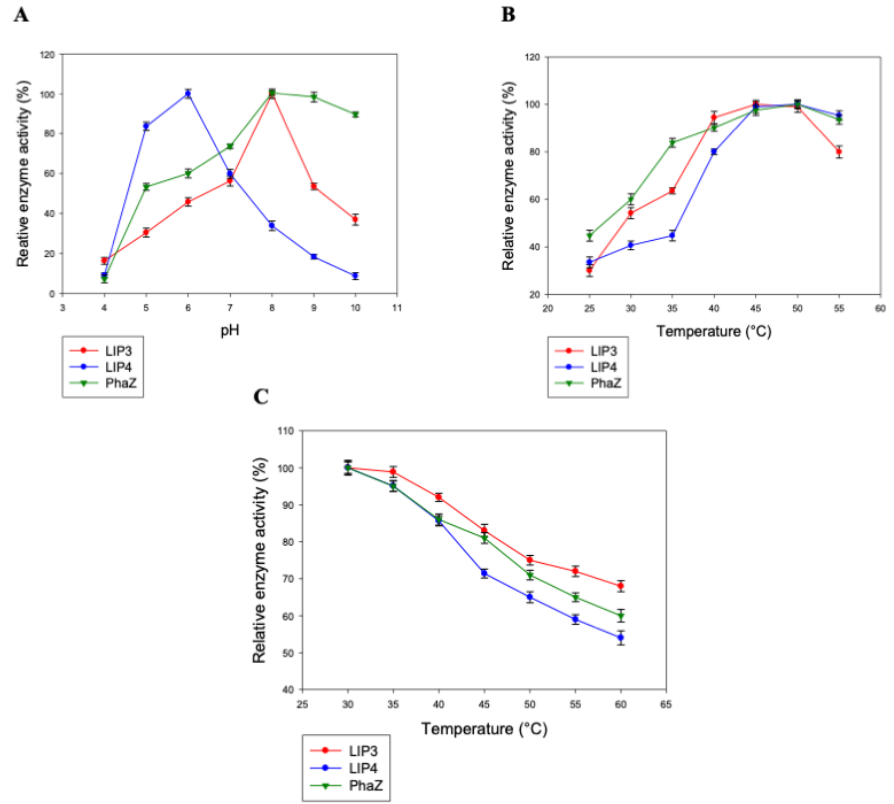
Figure 6. Determination of the parameters of enzymatic activity of LIP3, LIP4, and PhaZ. The effects of ( A ) pH and ( B ) temperature on the activity of LIP3 (red line), LIP4 (blue line), and PhaZ (green line). Recombinant LIP3 was optimally active at pH 8.0 and 45 ◦ C, LIP4 at pH 6.0 and 50 ◦ C, and PhaZ showed maximum activity at pH 8.0 and 50 ◦ C. The observed maximum activity was taken as 100%. ( C ) The red line shows the effect of temperature on the stability of LIP3; the blue line the effect of temperature on the stability of LIP4; the green line shows the effect of temperature on the stability of PhaZ. Thermal stability of enzymes was measured over a period of 24 h (h) at various temperatures (30–60 ◦ C). As a control, the activity of the untreated enzyme (0.025 mg/mL) was set at